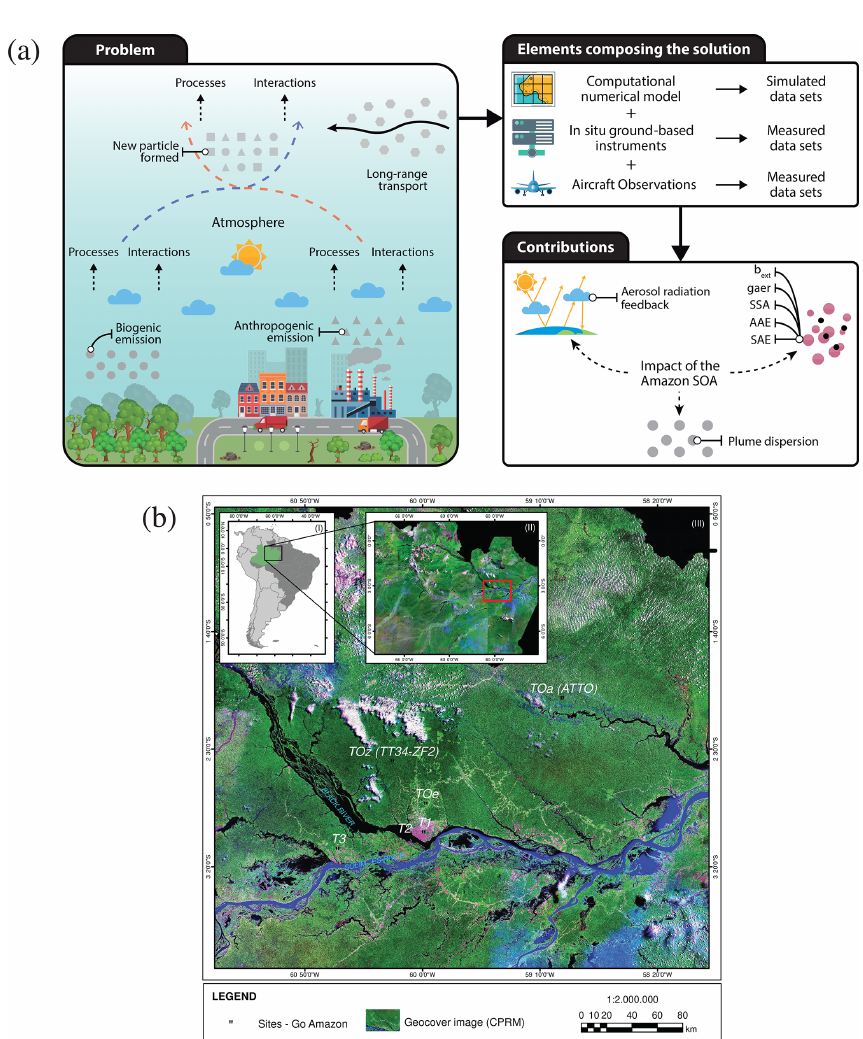
Figure 1. (a) Problem: the atmosphere has different natural and anthropogenic sources and the interactions between them. The elements composing the solution include computational numerical model and observational data sets. The contributions are understanding the impact of the Manaus air pollution plume on aerosol optical property variability over the Amazon rainforest during the GoAmazon (Green Ocean Amazon) 2014–2015 experiment. (b) Sampling stations TT34-ZF2 (T0z; ca. 60km northwest) and Amazon Tall Tower Observatory (ATTO; T0a; ca. 150km northeast) are both upwind of Manaus; downtown Manaus (T1), Tiwa Hotel (T2; ca. 8km southwest) and Manacapuru (T3; ca. 70km southwest) are all downwind of Manaus. The insets show a map of (I) South America and Brazil and (II) a magnified view of the Amazon region, with the red rectangle indicating the area where the GoAmazon 2014–2015 experiment meteorology stations were located and the region used for the WRF-Chem